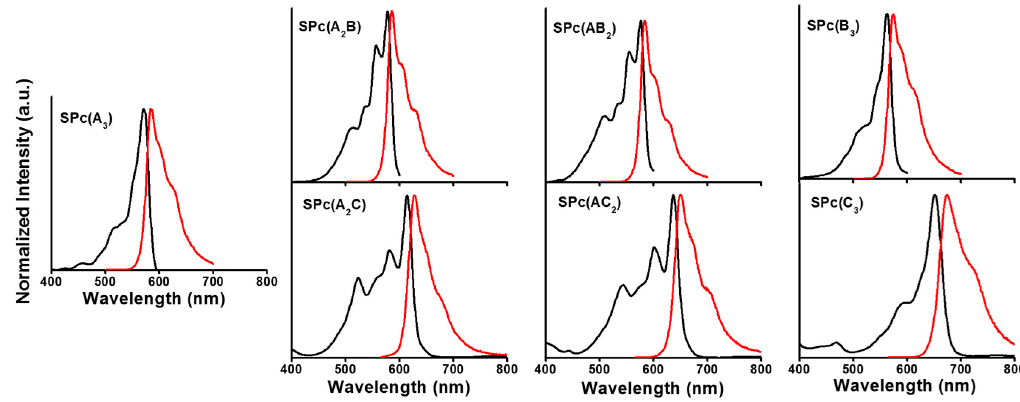
Figure 2. Electronic absorption ( black ) and emission ( red ) spectra for mixed fluorinated SPcs.